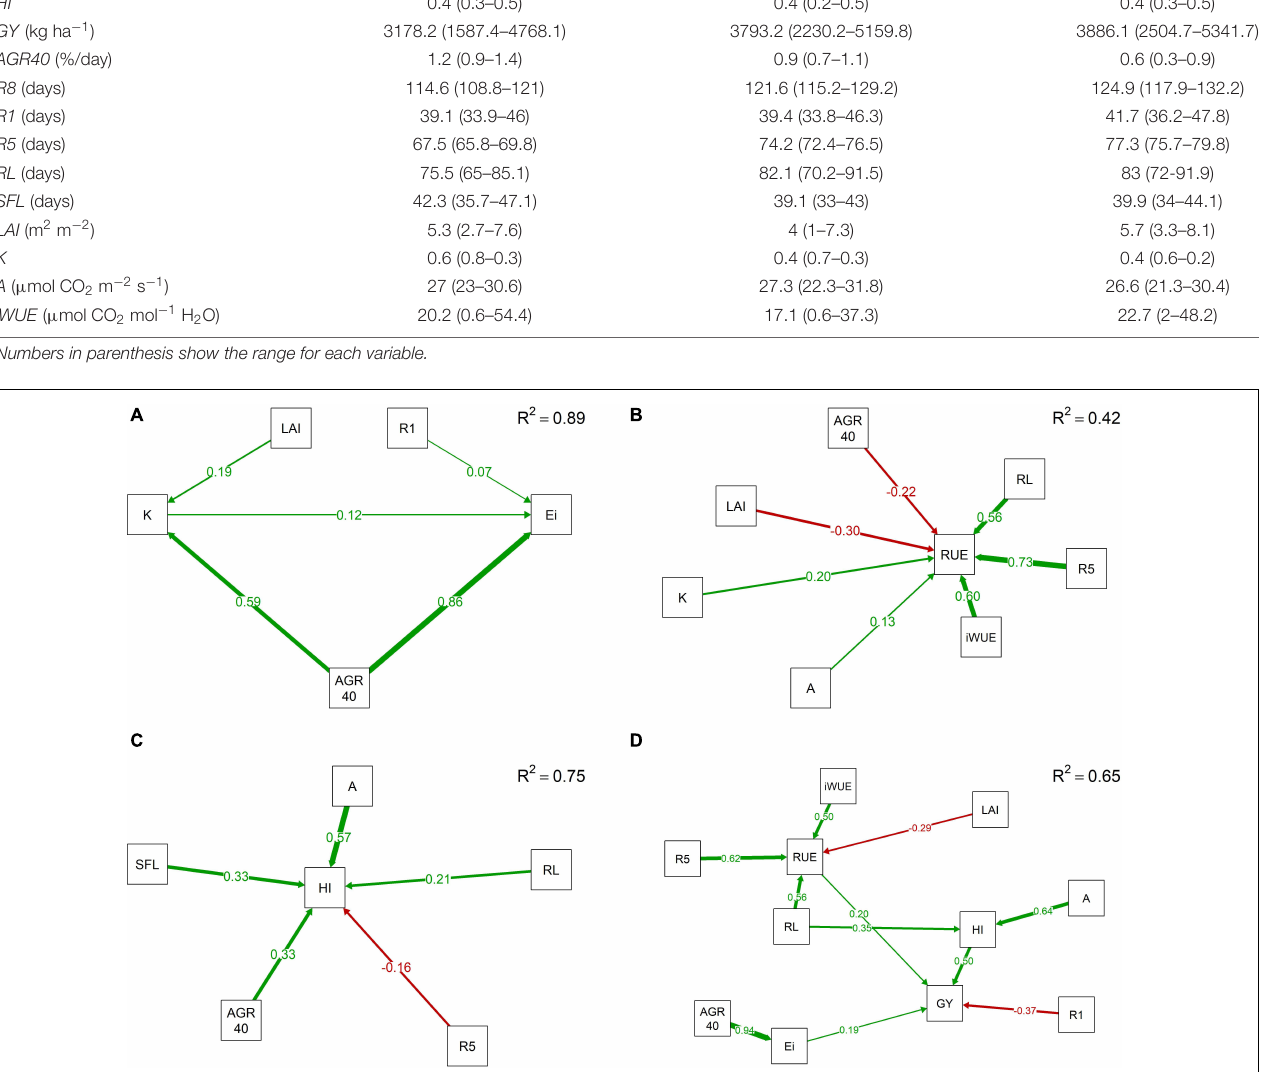
FIGURE 1 | Directed models through path analyses for additive–genetic relationship among physiological and phenological traits with light interception efficiency ( Ei ) (A) , radiation use efficiency ( RUE ) (B) , harvest index ( HI ) (C) , and grain yield ( GY ) (D) in a maturity-controlled panel of soybean. Three hundred eighty-three recombinant inbred lines (RILs) evaluated in three environments. A , photosynthesis; AGR40 , average canopy coverage growth rate during the first 40 DAP ; K , light extinction coefficient; iWUE , intrinsic water use efficiency; LAI , leaf area index; R1 , days to flowering; R5 , days to beginning of seed formation; R8 , days to maturity; RL , reproductive period length; SFL , seed-filling